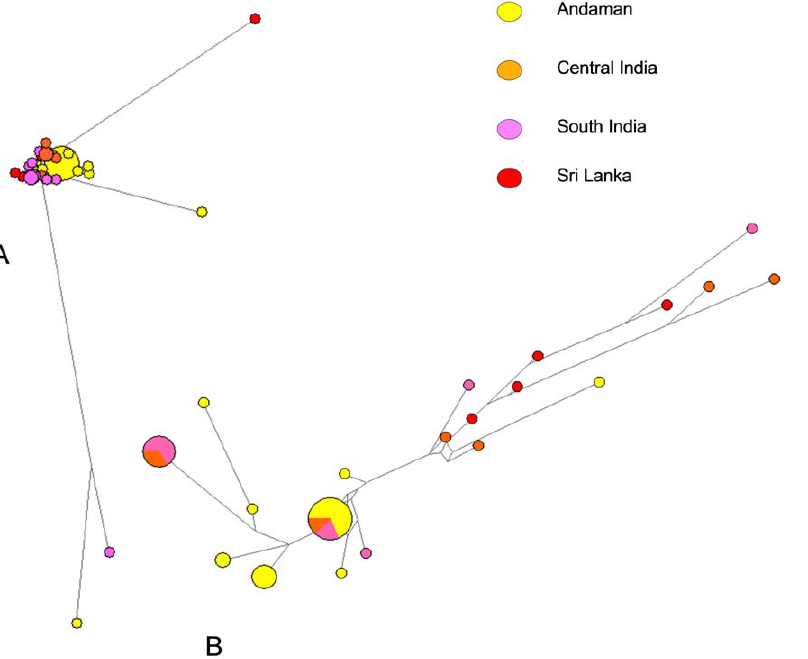
Figure 4. Median-joining network analysis of the MLST data obtained for the Indian (sub continent) subsample of L.interrogans . As evident from the trees A and B, a few sequences were highly divergent, possibly because of recombination. The enlargement of the core sequence network (B) revealed four sequences from the Andaman Islands in the central position, suggestive of a possible source of the Indian L. interrogans variability, followed by distinct derived clusters from South India, Central India and Andaman islands. Such a geographic structure is not apparent in the FAFLP network (Figure 1) of the Indian L. interrogans , confirming the reduced phylogenetic resolution of FAFLP in respect to MLST analysis. The color codes have no overlaps with those shown in Figures 1, 2 and 3. The tree/associations were deduced using Network 4.5.0.0 package.